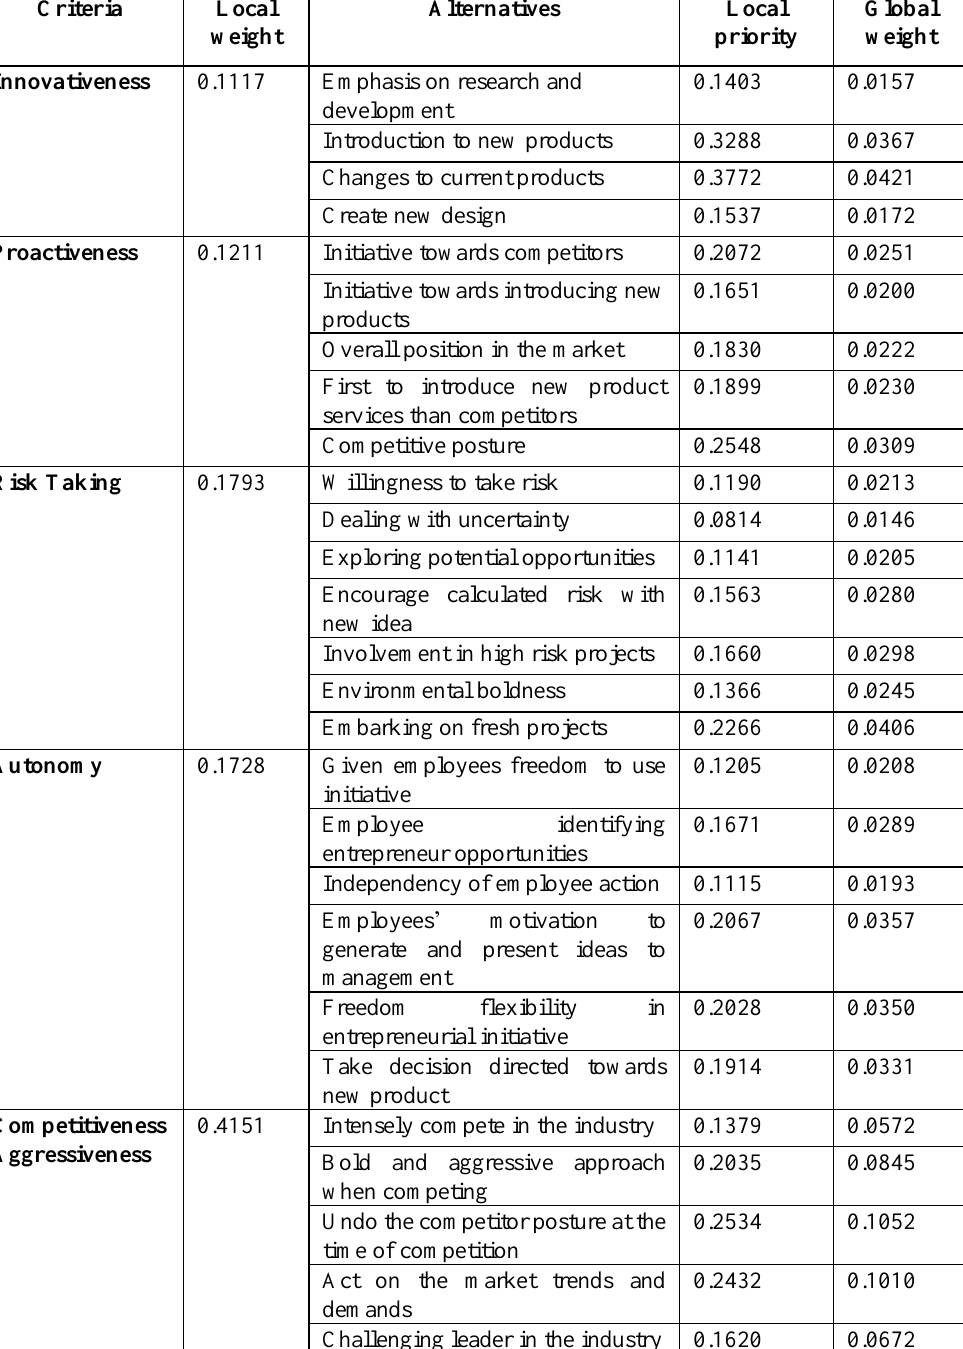
Table 3. Tabular Presentation of the Decision Criteria and Alternatives with their